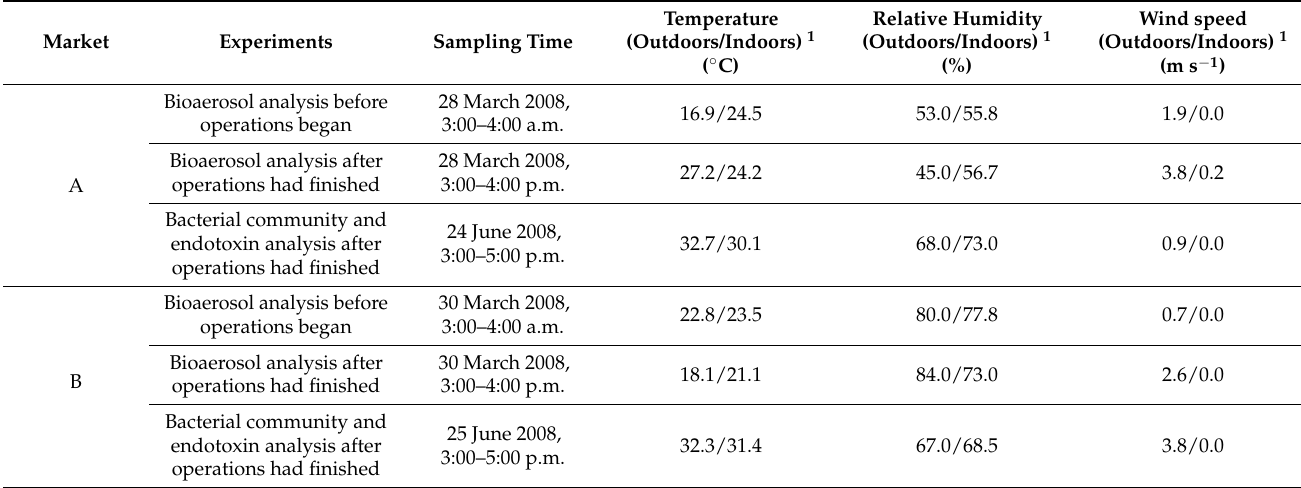
Table 2. Bioaerosols sampling times and environmental conditions at the two indoor